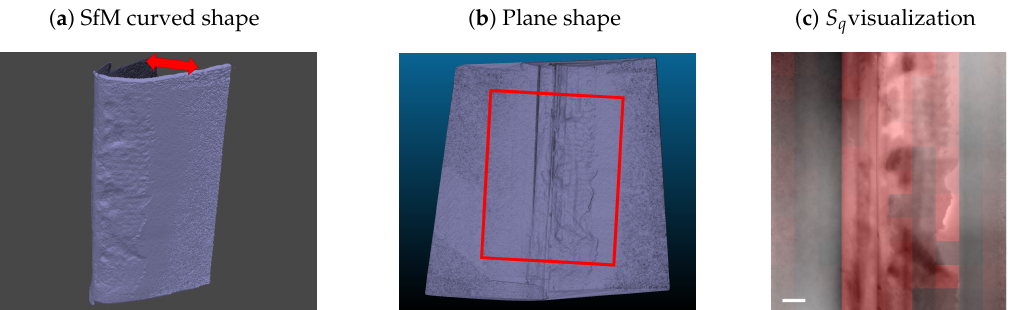
Figure 7. Visualization of LER. The curved blade geometry seen in ( a ) was unfolded to a flat shape shown in ( b ) from which a region centered on the LE was selected as indicated by the box. For each 10 mm × 10 mm square in the region, the S q parameter was calculated. In ( c ), the strength of the red color indicates the S q value in each square. The scalebar is 10